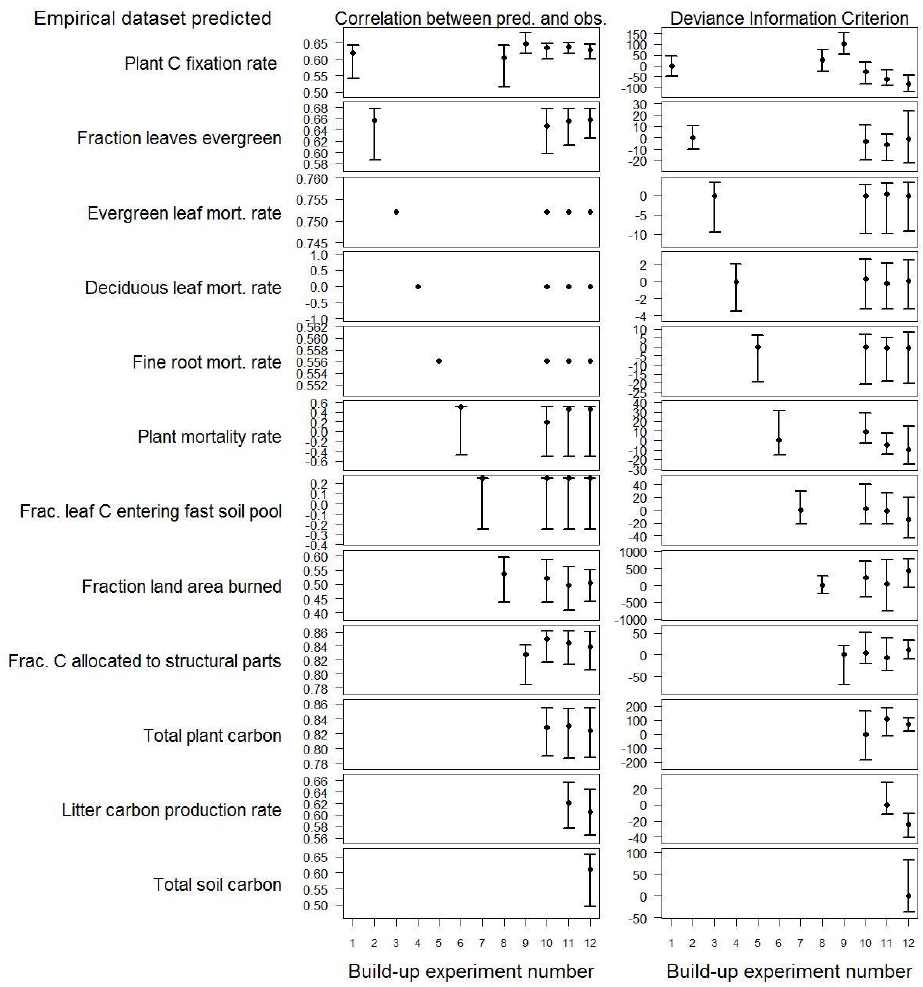
Fig. 7. Correlations between model predictions and hold-out evaluation data (left) and deviance information criterion (DIC) values (right) obtained from different model fitting experiments (Gelman et al., 2004). DIC values have been normalised relative to the lowest build-up experiment number predicting the data set indicated. The presence of confidence intervals for a given experiment number indicates whether a model component was used in a model fitting experiment. Points represent the average median estimate using the parameter probability distributions obtained from 10-fold model fitting, and the whiskers are average 95% confidence intervals.